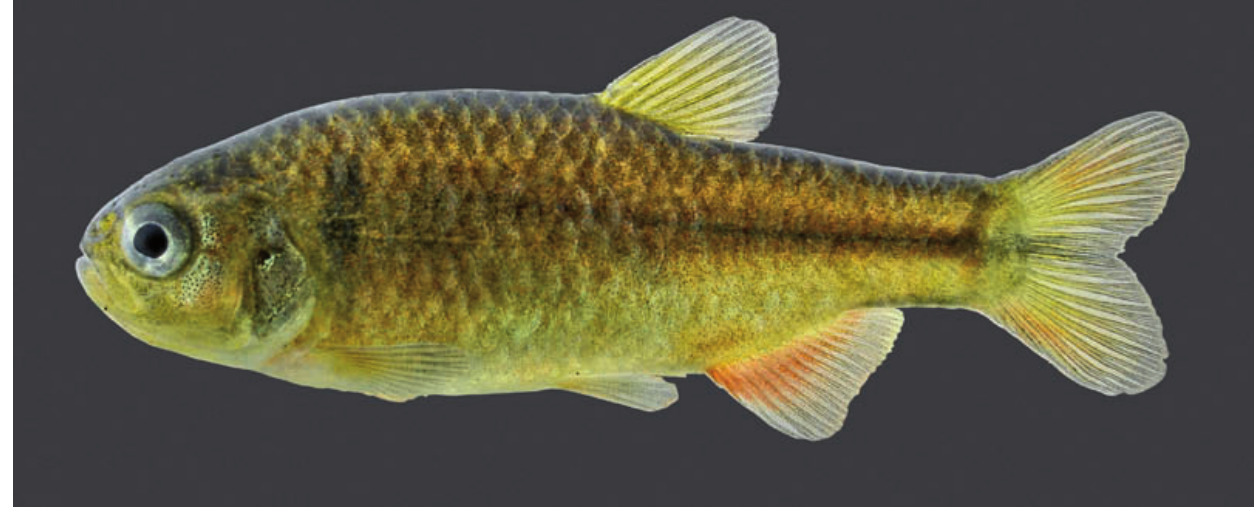
Fig. 2. Hasemania piatan , freshly preserved paratype showing living color pattern, UFBA 4299, 37.5 mm SL; Brazil, Bahia, Piatã, riacho Três Morros, tributary of rio de Contas drainage.